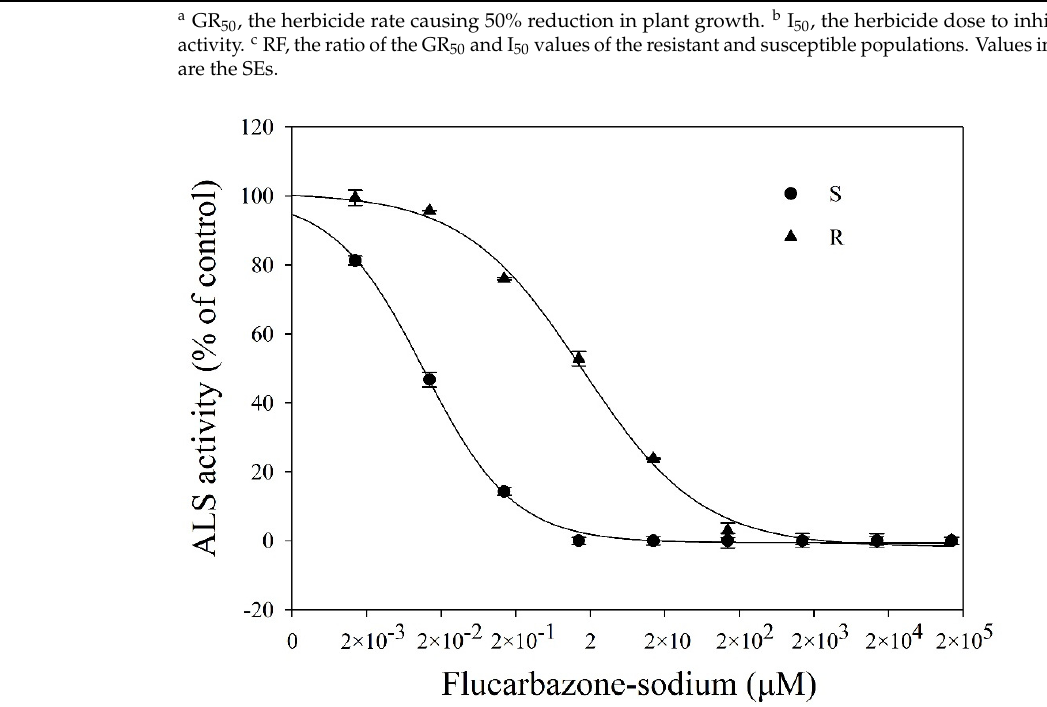
Figure 3. Dose-response curves of ALS activity in the S and R populations. ALS activity is expressed as a percentage of activity based on the untreated control. Vertical bars indicate the SEs (both R 2 > 0.99).